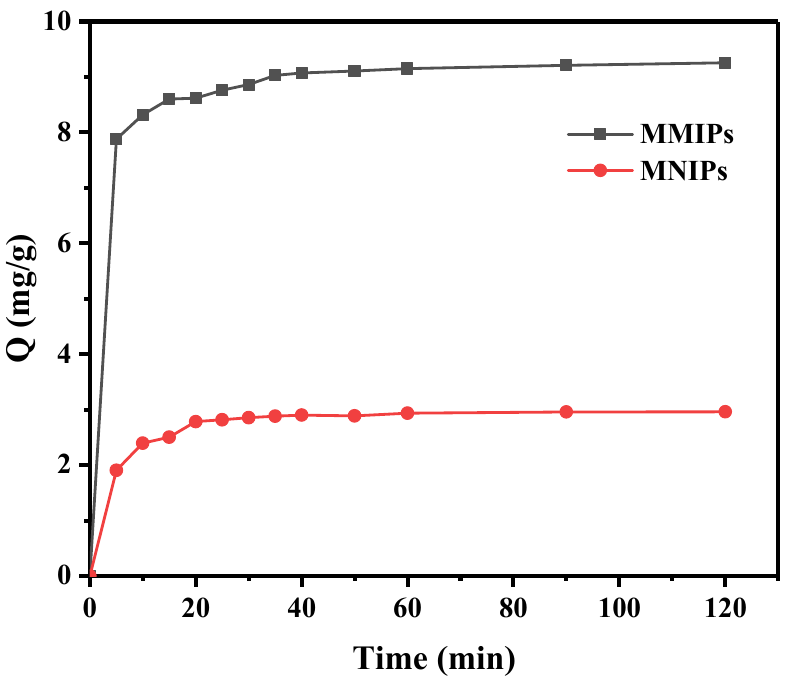
Figure 5. Adsorption kinetic curves of MMIPs and MNIPs. Conditions: [E2] 0 = 5 mg/L, [MMIPs or MNIPs] 0 = 0.5 g/L, T = 30 °C, and pH = 6.0.